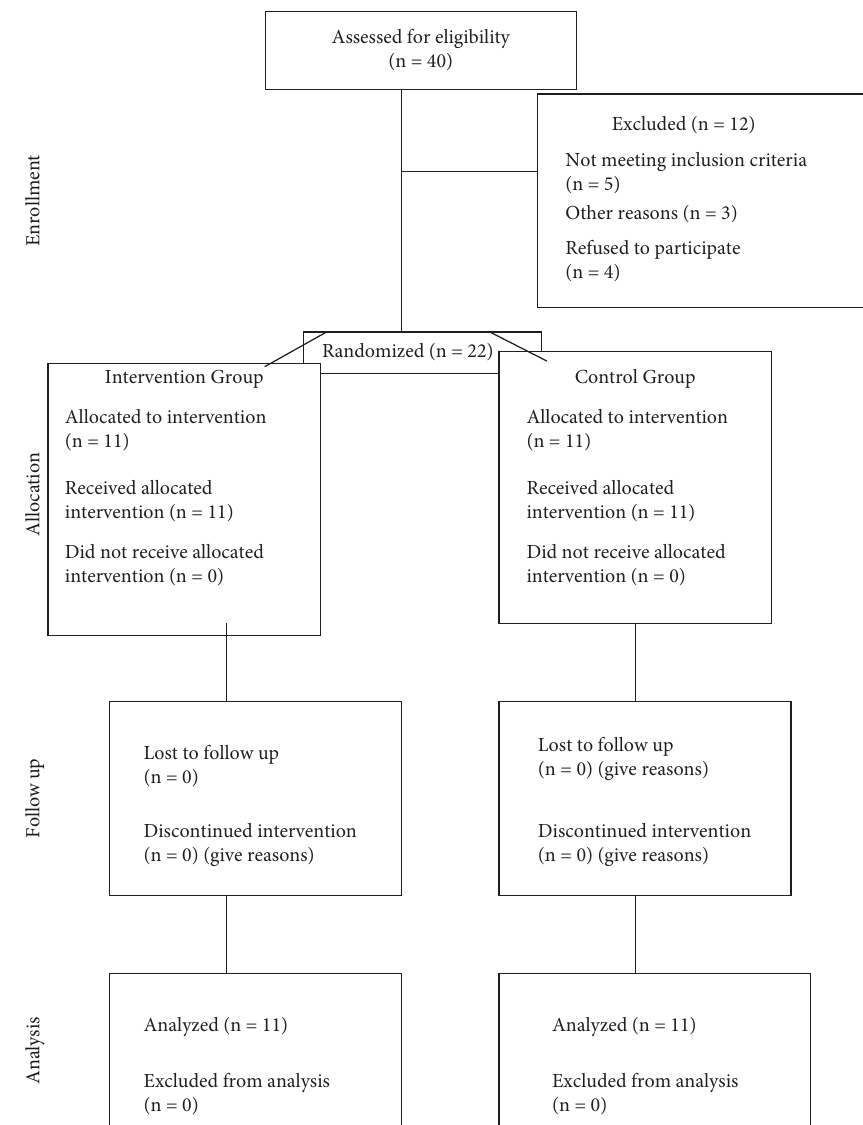
Figure 1: CONSORT diagram showing the fow of participants through each stage of a randomized trial. Table 1: Mean size of PA lesions at baseline and at 1 and 3months after endodontic treatment in the two groups. Group